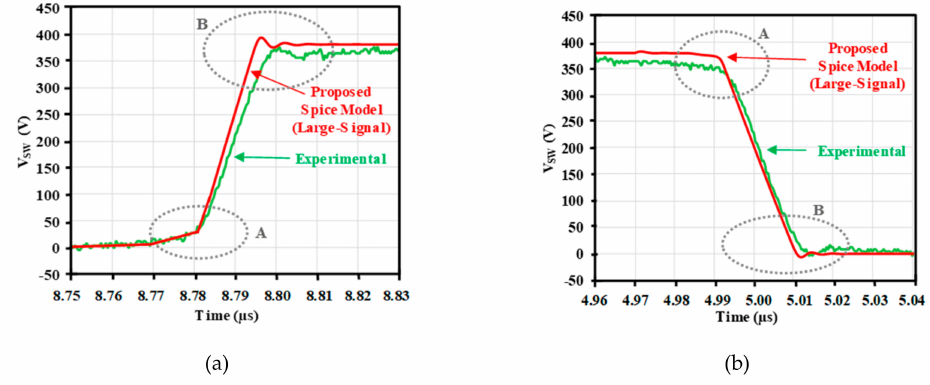
Figure 11. V SW waveform extracted by experimental measurement (green) and simulation with the proposed large-signal spice model (red) during ( a ) the increase of V SW and ( b ) the decrease of V SW . It should be noted that the equivalent capacitance seen from the port defined by V SW is the